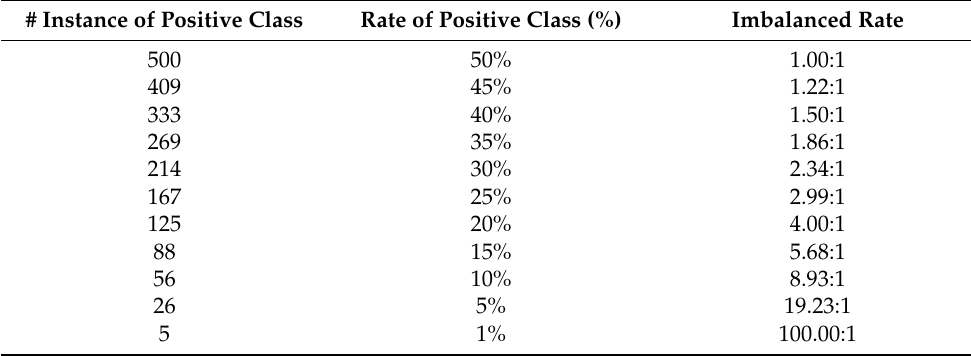
Table 1. Different levels of imbalance for the generation of artificial